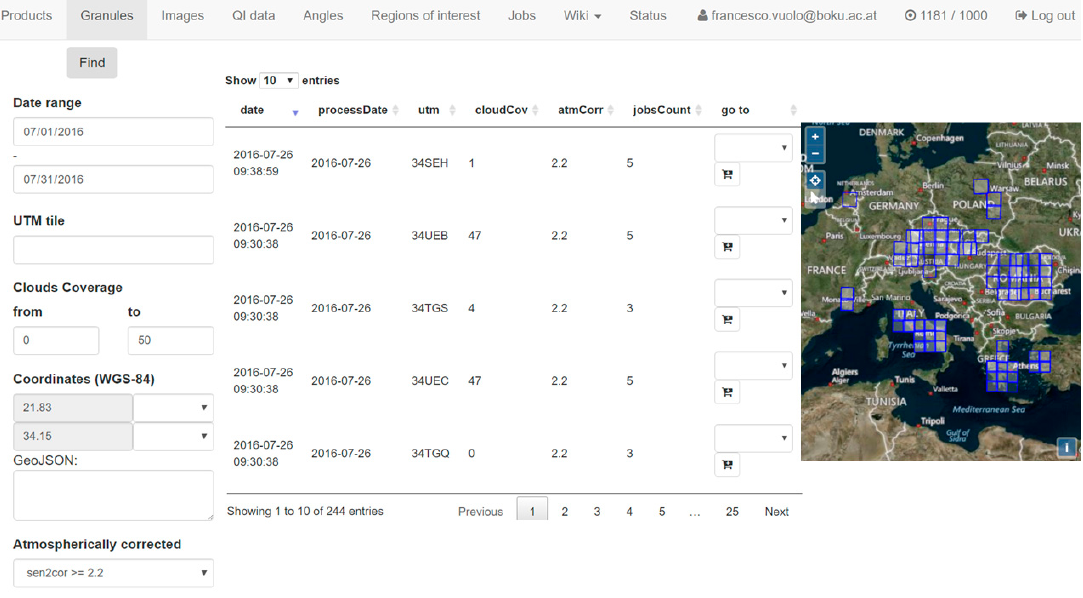
Figure 3. Web interface to explore the data archive, access Sentinel-2 data and value-added products. The map shows the footprint of the atmospherically-corrected granules processed over part of Europe in July 2016.